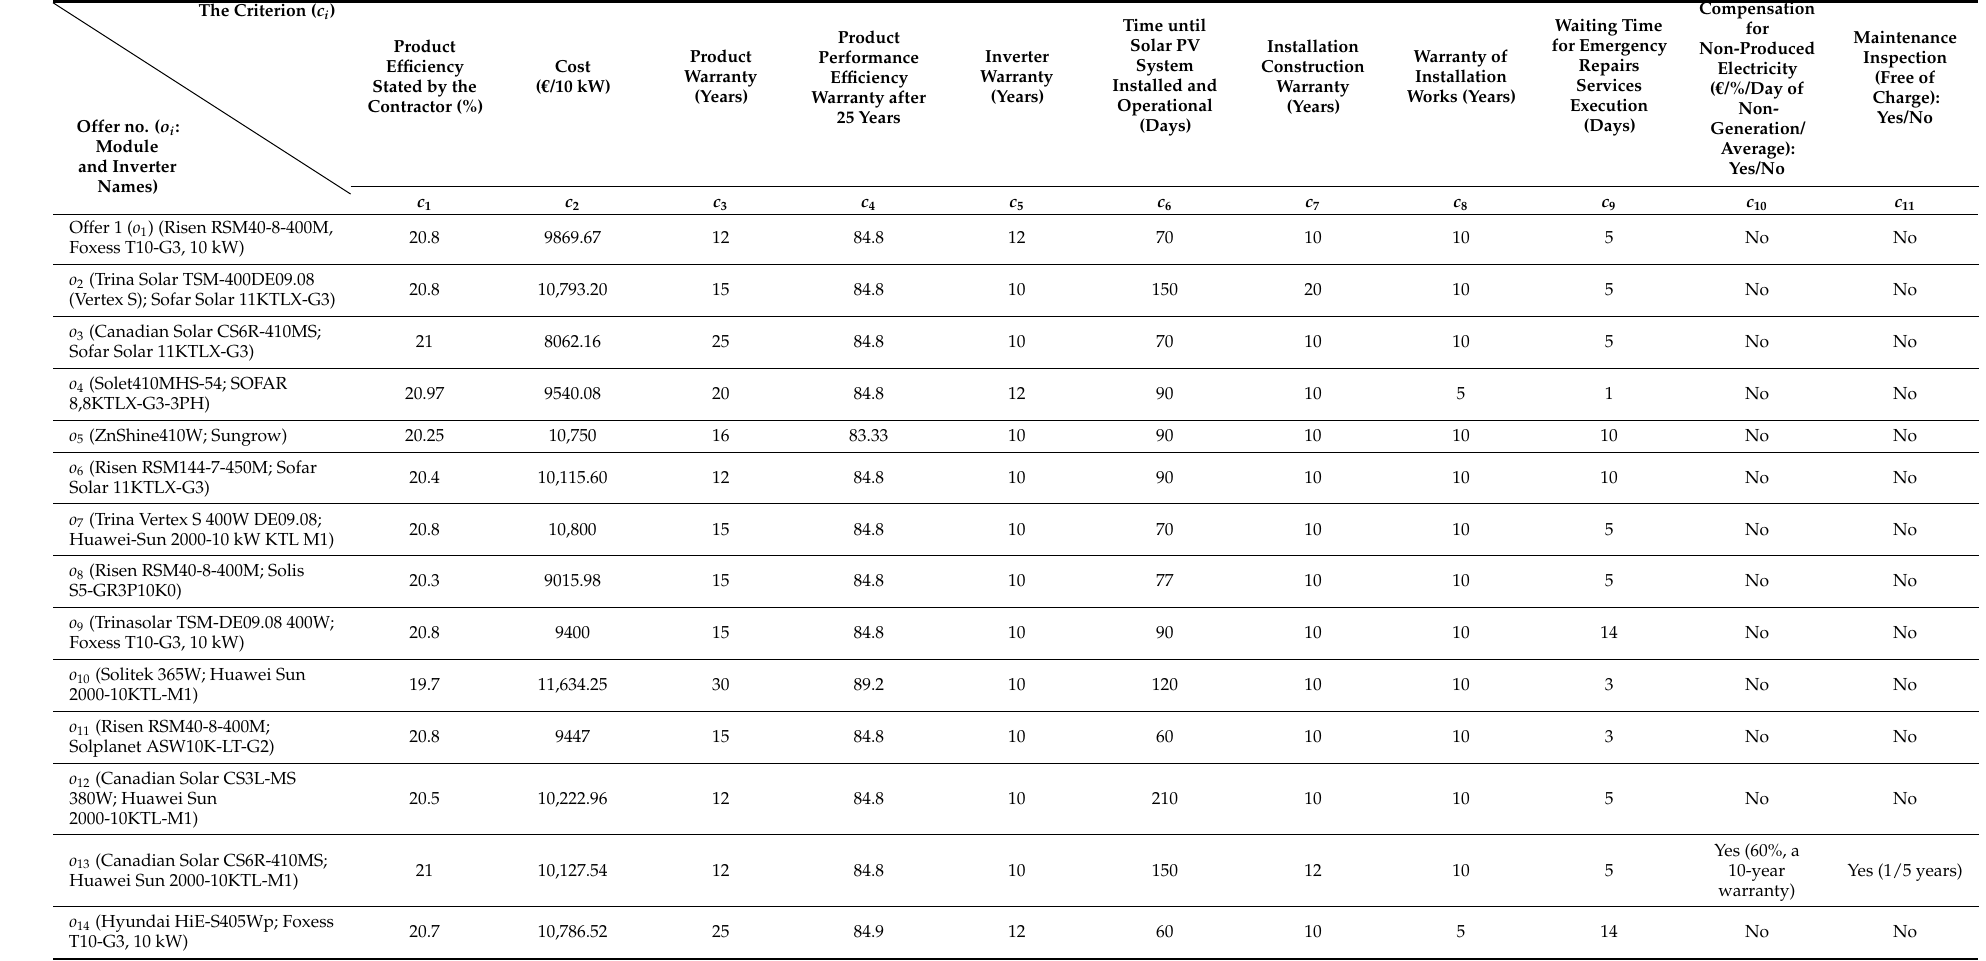
Table 3. Summary of offers received from contractors of a rooftop solar PV system with a 10 kW electricity generation